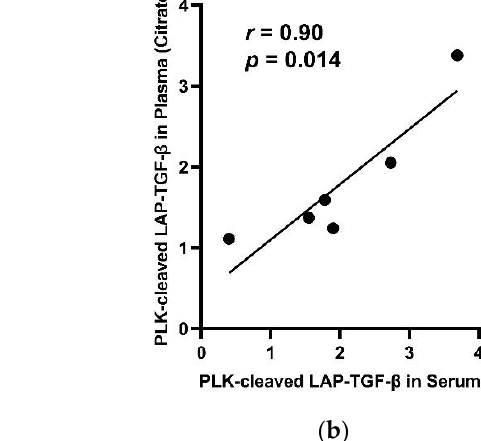
( b ) Figure 4. Diagnostic potential of PLK-cleaved LAP-TGF- β: ( a ) Serum levels of PLK-cleaved LAP-TGF- β in healthy indi- viduals (n = 20) and patients with PDAC (n = 34). Black lines indicate median values. Patients in stages 1, 2, 3, and 4 have shape and color codes being green square, purple diamonds, light blue triangles, and orange circles, respectively. ( b ) Receiver operating characteristic curve for the patients and healthy individual mentioned in (a), area under curve (AUC).